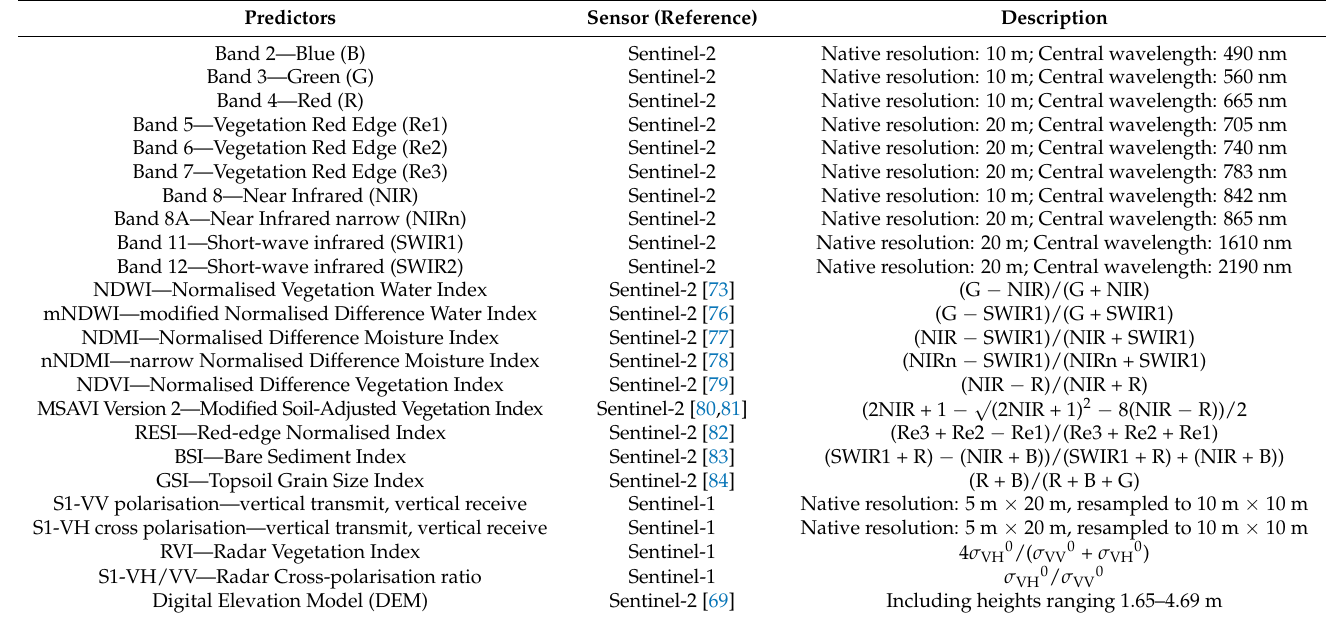
Table 1. Description of predictors considered for the supervised classifications, including a selection of relevant Sentinel-2 spectral bands, Sentinel-1 Synthetic Aperture Radar VV and VH polarisation bands, a selection of indexes derived from both sensors, and the digital elevation model produced in this study. σ VH0 and σ VV0 are the radar backscattering coefficients in decibels for the VH and VV polarisation bands, respectively, obtained during the radiometric calibration of radar intensity